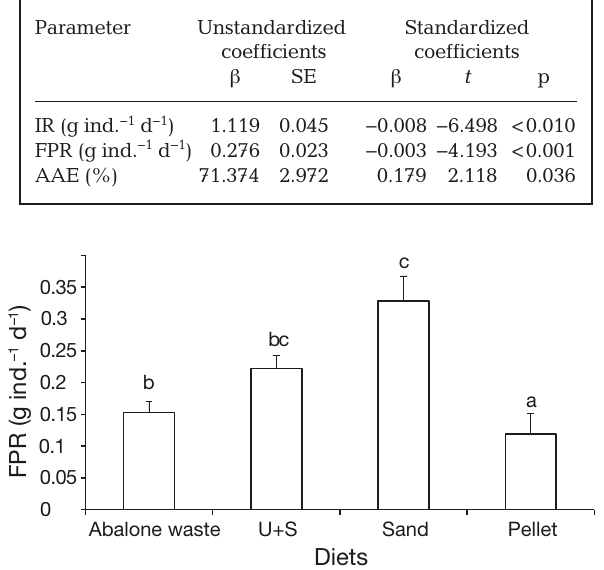
Fig. 2. Mean (+SE) faecal production rate (FPR) of Neosti- chopus grammatus fed 4 experimental diets (n = 32). Differ- ent letters above each bar indicates a significant difference between treatments (Dunn, p < 0.05). U+S: Ulva